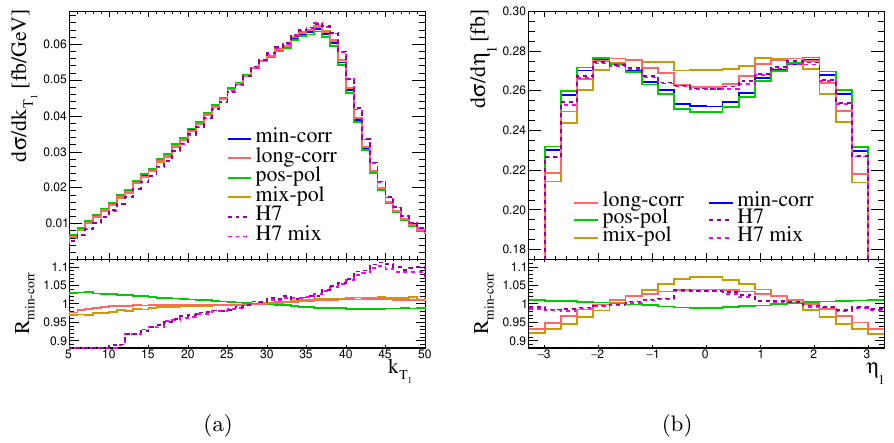
Figure 6 . The distributions of the (cid:12)nal-state muon transverse momentum and rapidity for the di(cid:11)erent models. The distributions for (cid:22) 2 are identical (except the one for H7 model). The ratio R min-corr shows the comparison of di(cid:11)erent models to the min-corr scenario. We initially calculate the partonic cross section di(cid:11)erential in four variables ( k (cid:17) , and (cid:17) ), with the methods of section 4 using the di(cid:11)erent DPD models (see section 3). 1 2 We divide the phase-space region (4.1) into almost half a million subregions with unequal sizes. The same four-dimensional quantity is then obtained from the event generator and compared to the theoretical results at the parton level. According to this comparison, we appropriately change the default weights of the Herwig events. After the event